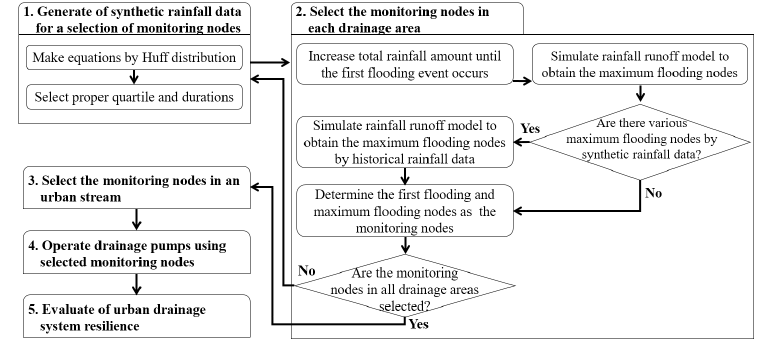
Figure 5. The flowchart for this study.